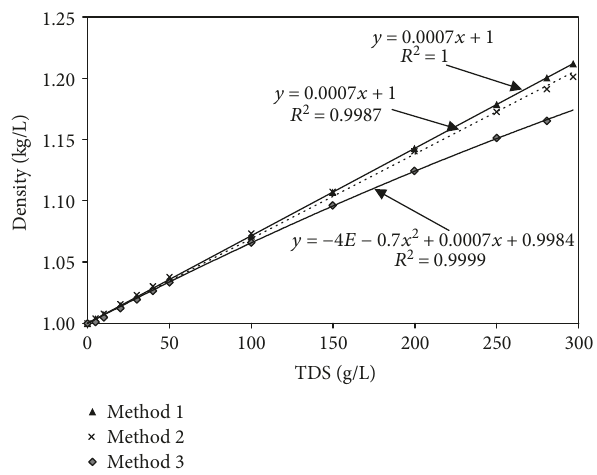
Figure 3: Relationship between the natural water densities calculated using di ff erent methods and